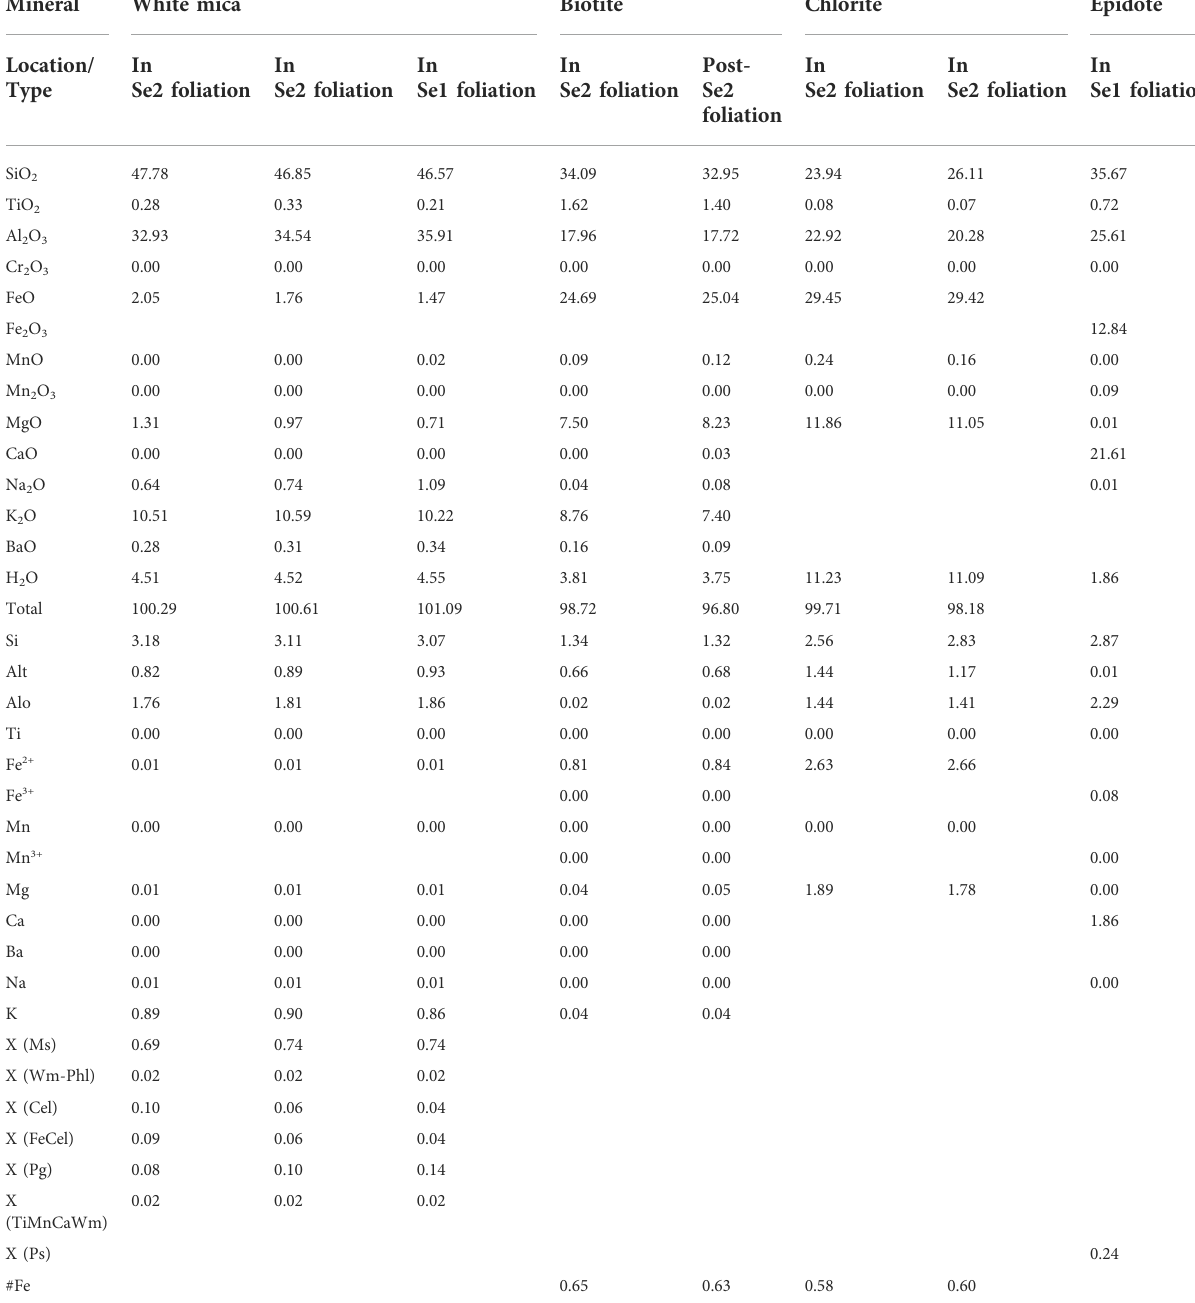
TABLE 4 Representative analyses of white mica, biotite, chlorite, and epidote from the FO1710 garnet bearing mica schist sample. Mineral White mica Biotite Chlorite Epidote Location/